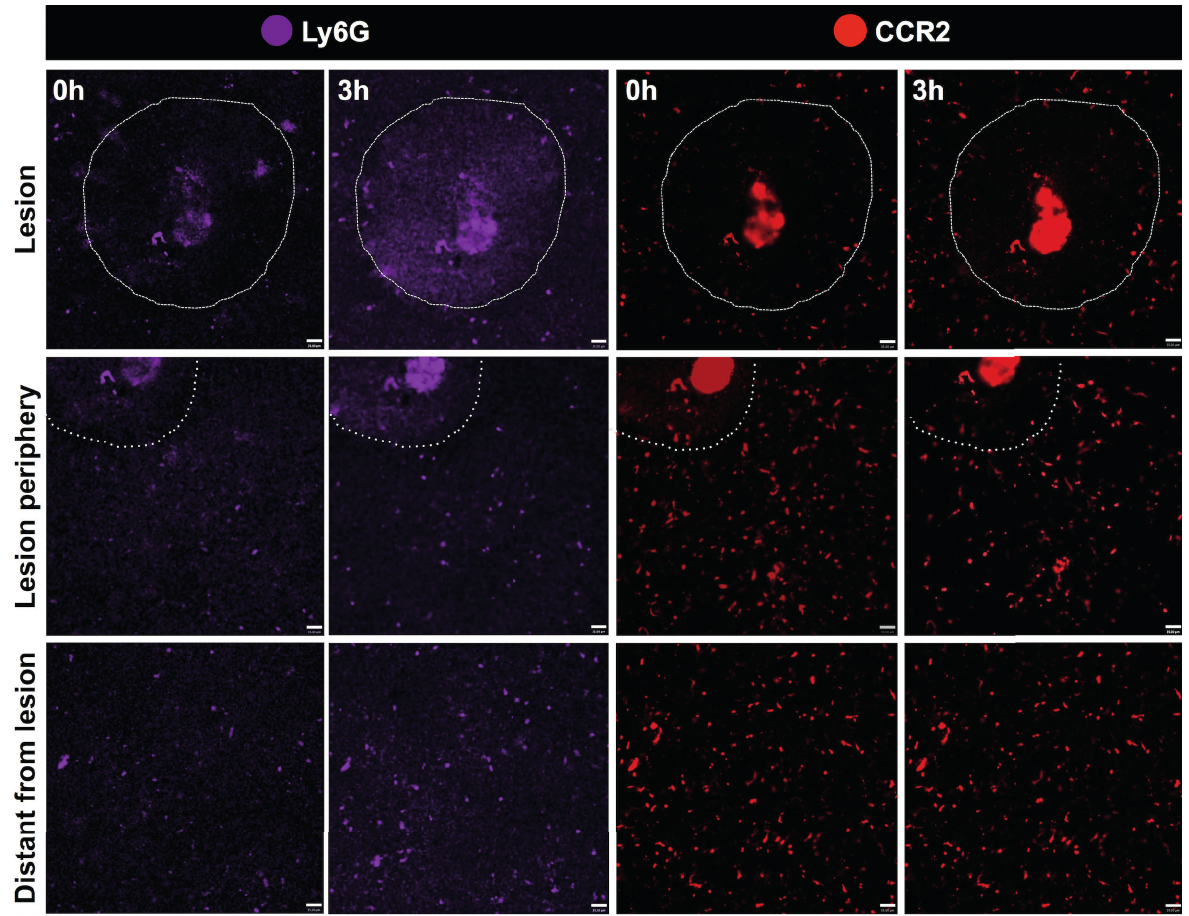
Figure 8 - Dynamics of phagocytic populations under liver injury. Assessing migration dynamics of ly6g + (purple) and CCR2 + (red) to necrotic zones, areas around necrosis and areas distant from necrosis using intravital microscopy. Imaging throughout three sequential hours. A hot needle, adapted to a cauterizer unit, induced liver injury. The needle was put on the liver surface and generated a punctual necrosis, which is delimited by the dotted line. Scale bars = 35